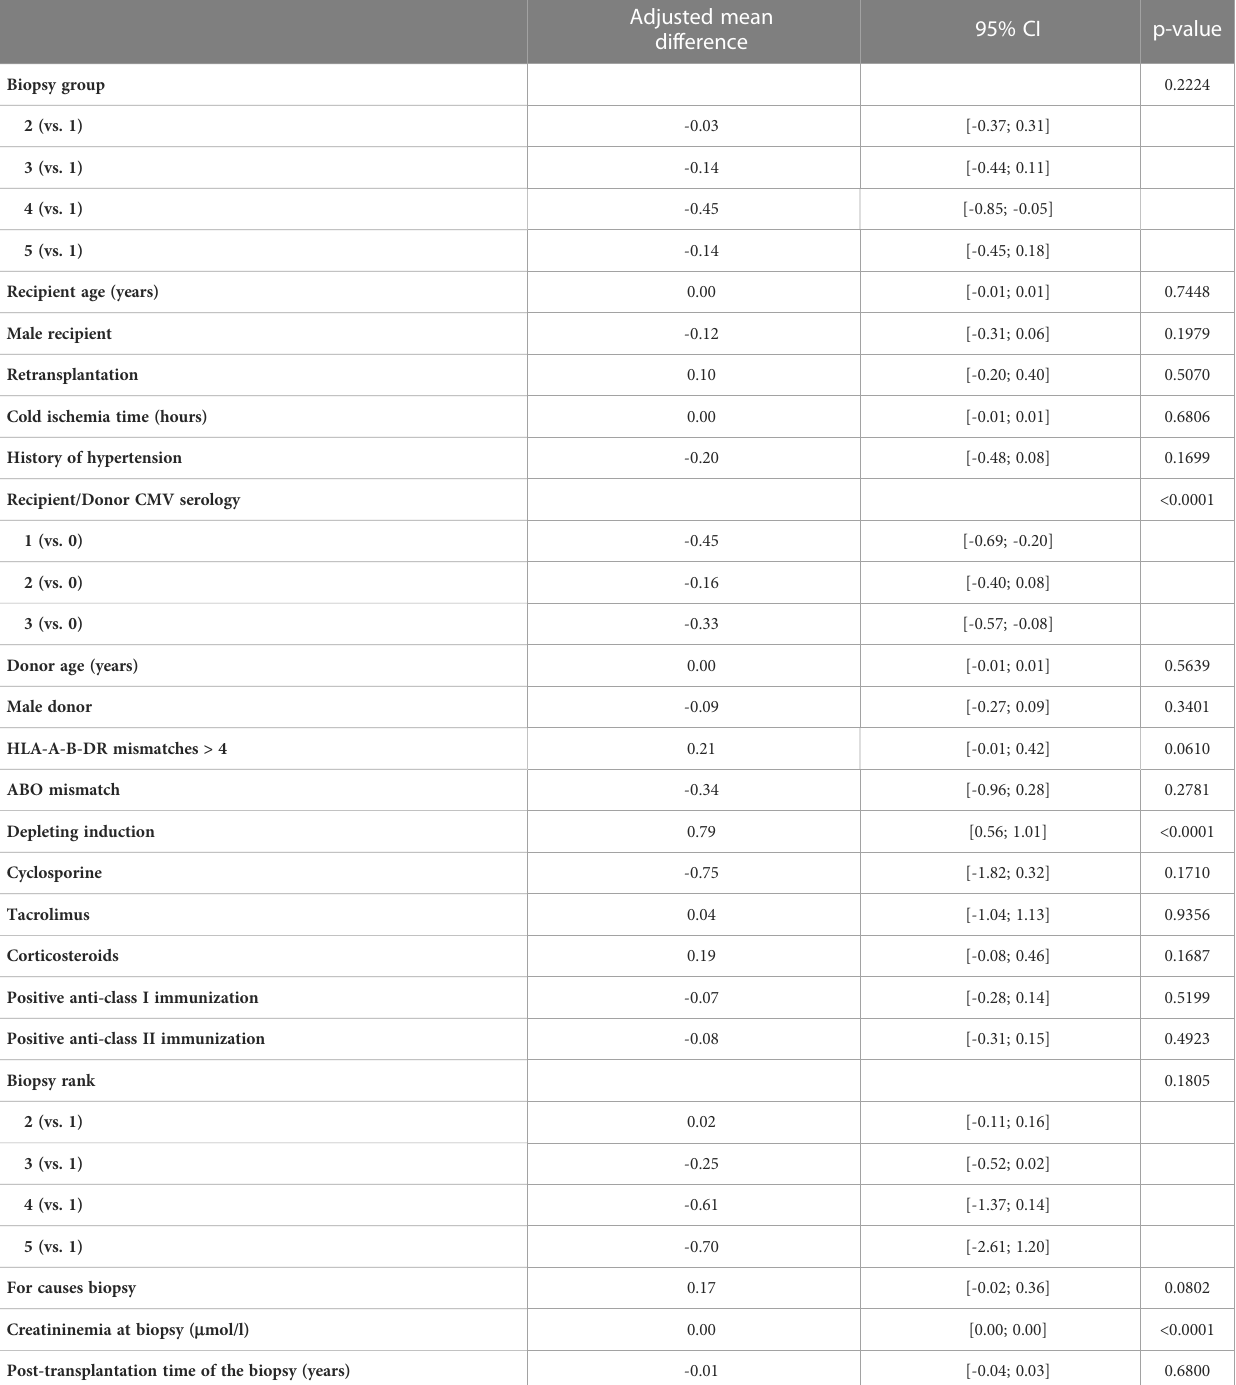
TABLE 2 Results of the multivariable linear mixed model of square root of B lymphocytes in percentage measured at the time of biopsy (5 biopsy